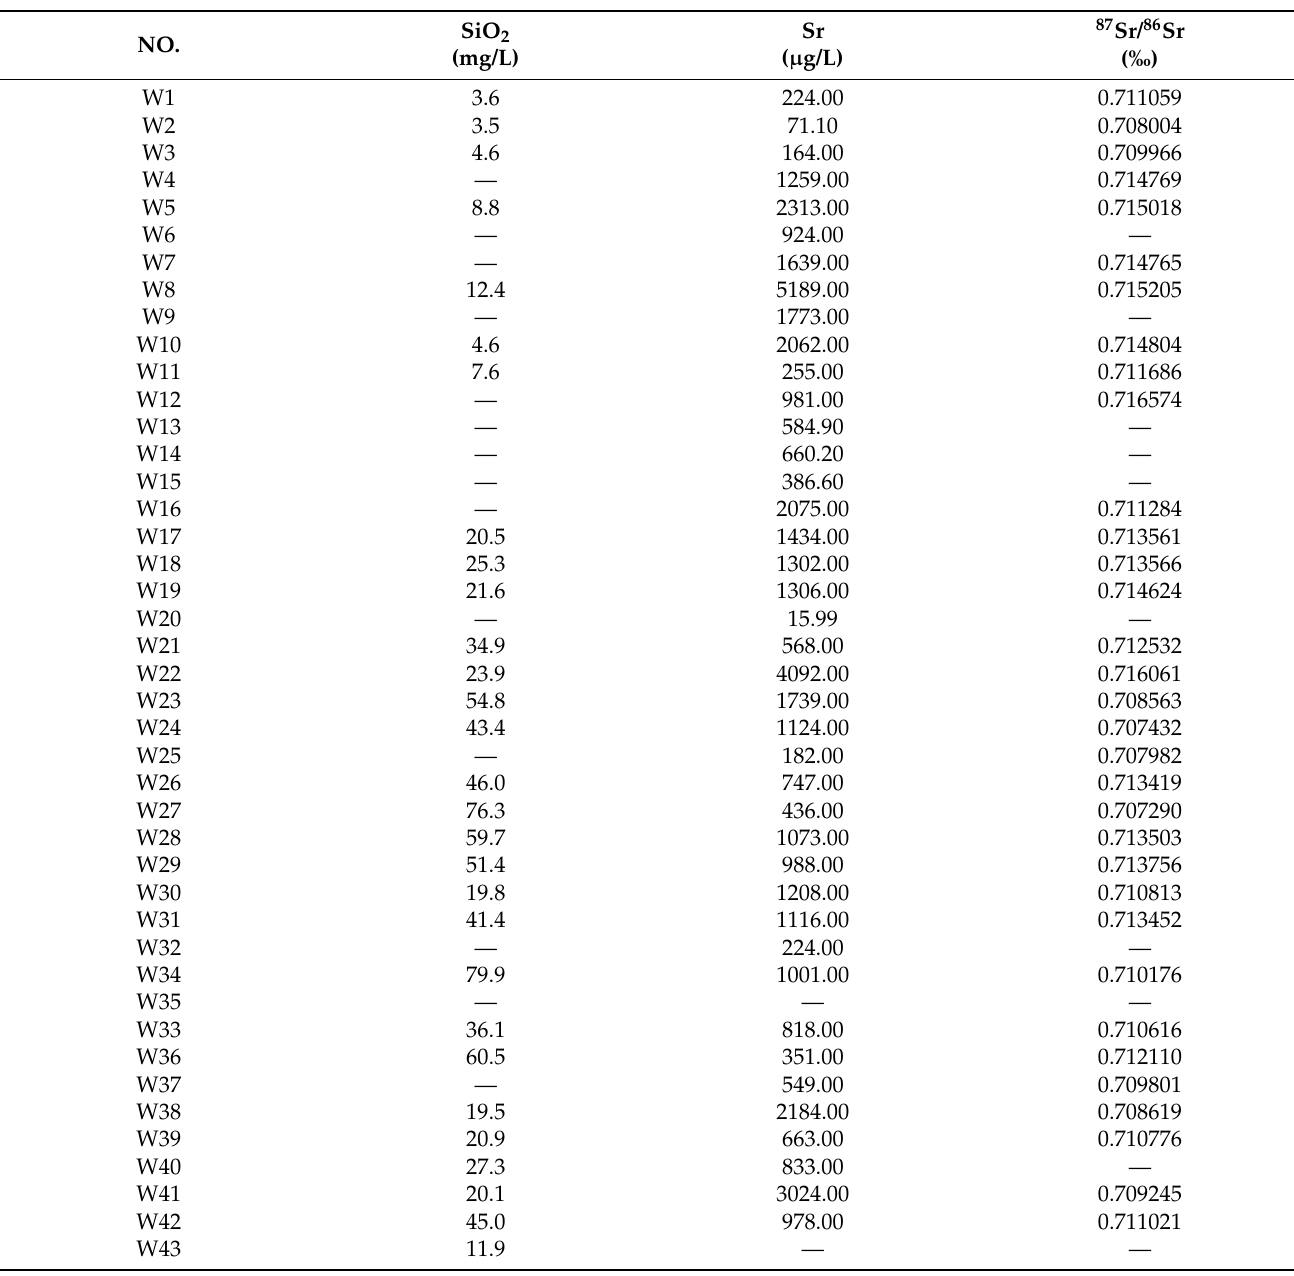
Table 2. The data of silicon dioxide, strontium and strontium isotope from hot